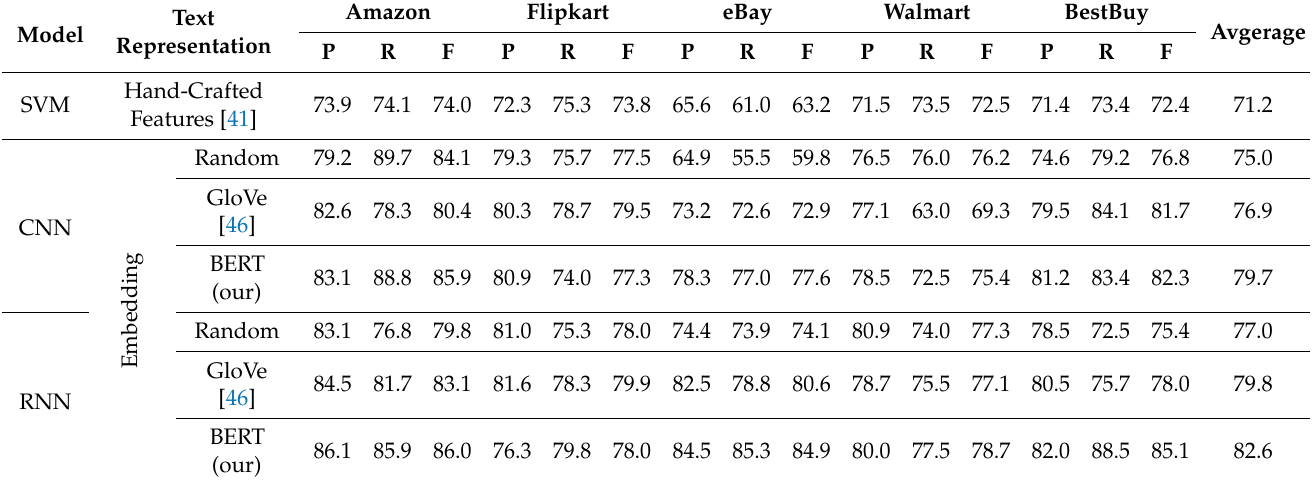
Table 6. Comparison results for hierarchical aspect-based opinion summarization phase in our system on our LC5 dataset. SVM: support vector machine; CNN: convolutional neural network; RNN: recurrent neural network.